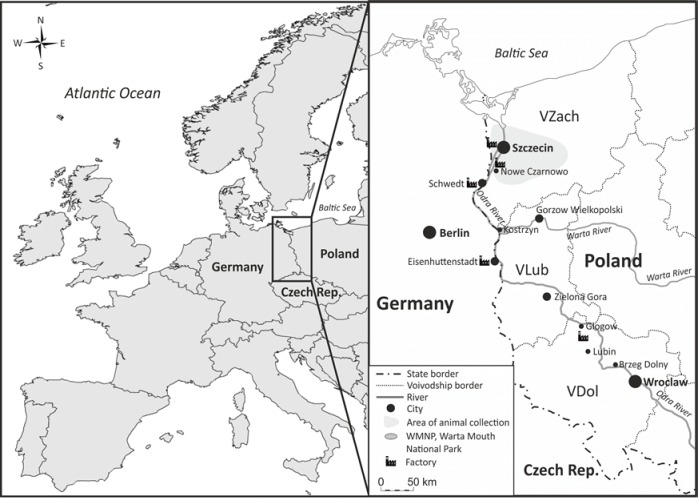
The area where the animals were collected is located at the Polish-German border.Winds in this part of Europe are mostly from south-west and organisms living in the area are exposed to emissions from both local and distant sources.